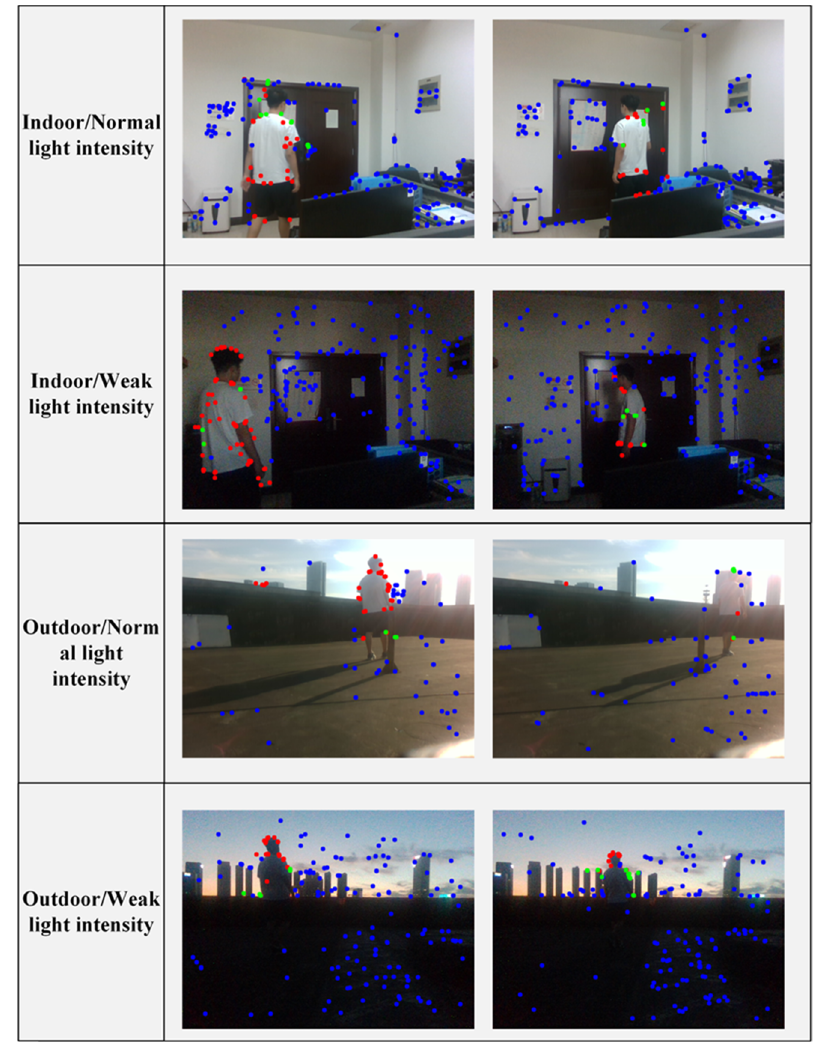
Figure 14. Filtering in different scenarios. The red points correspond to the dots filtered out during the first round. Green points correspond to the dots filtered in the second round.